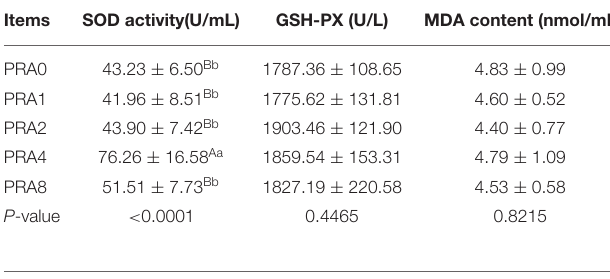
TABLE 7 | Effects of dietary PRA extract levels on serum immune indexes of raccoon dog.